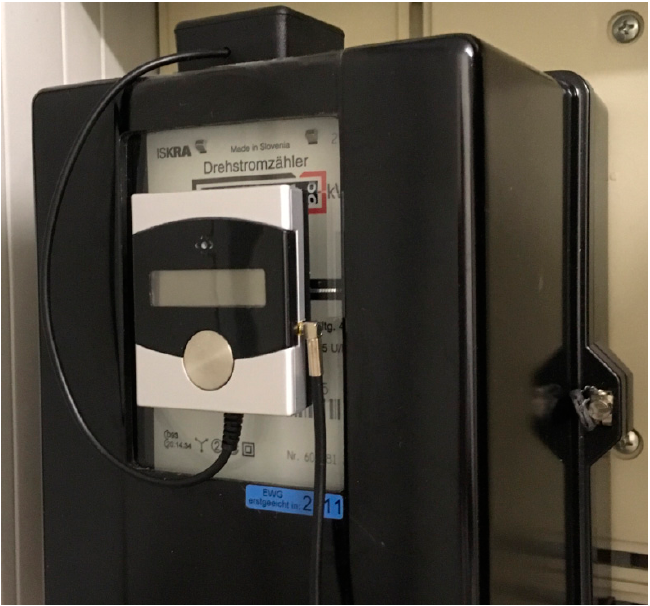
Figure 2. Mounted camera module on the analog energy meter.